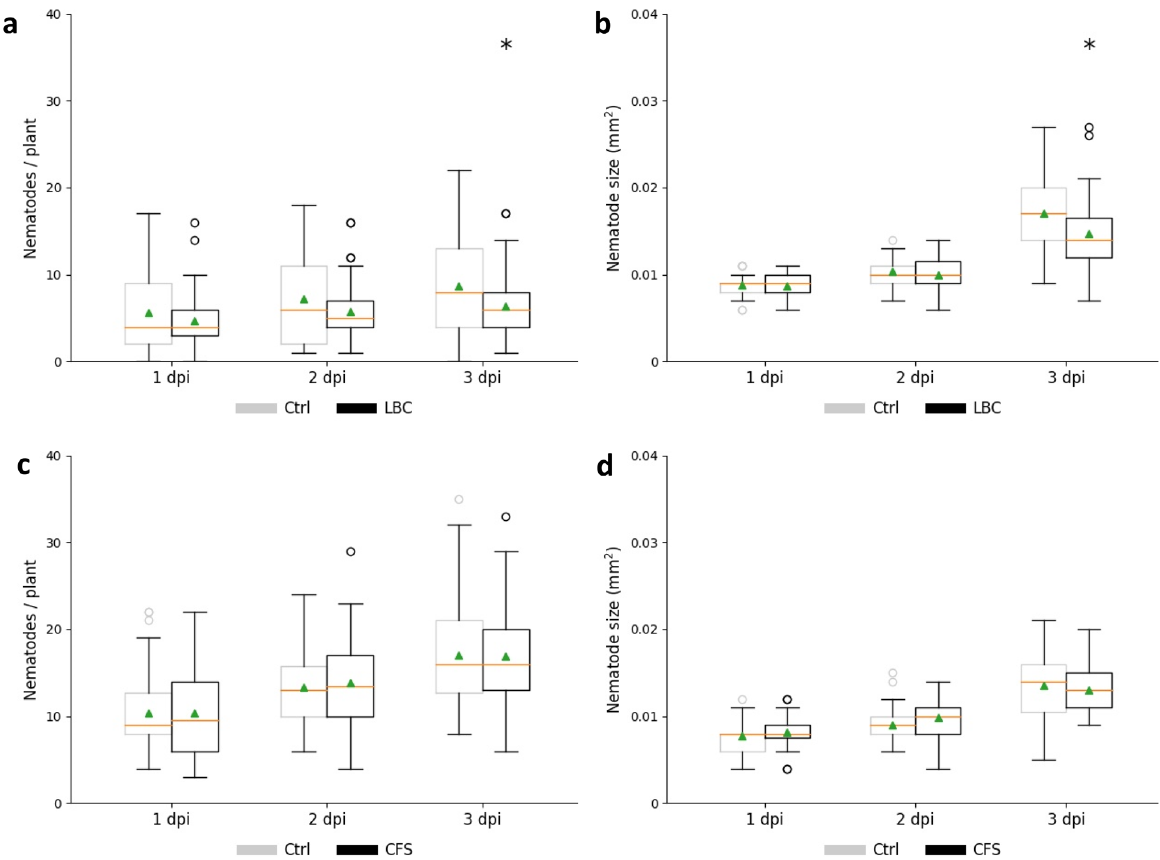
Figure 6. Invasion assay of Heterodera schachtii at Arabidopsis thaliana roots. Average number of nematodes per plant in the presence of LBC ( a ) or CFS ( c ); Average size of nematodes in the presence of LBC ( b ) or CFS ( d ). LBC living bacterial cells, CFS cell-free supernatant, dpi days post inoculation. Results are expressed as the mean (orange line) and median (green triangle) ± standard error of three independent biological replicates (n ≥ 37). Data are statistically analysed using Dunn’s or Holm–Sidak Method. Asterisk (*) indicate statistically significant differences compared with the control ( p <